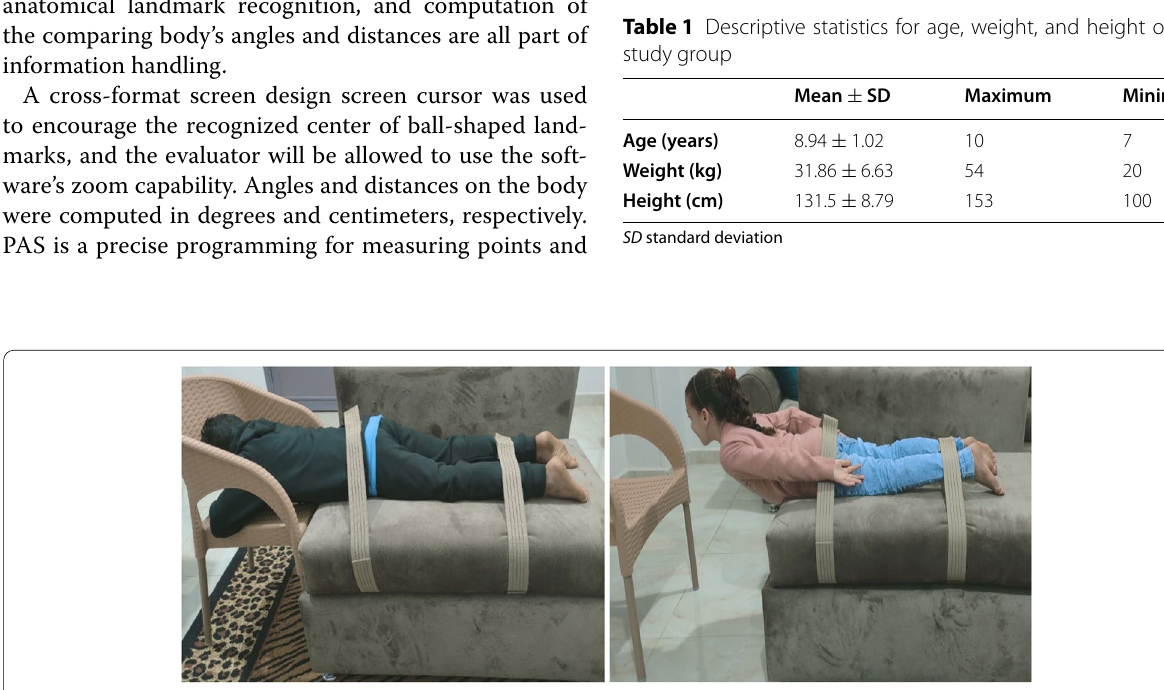
Fig. 2 Beiring Sorensen Test